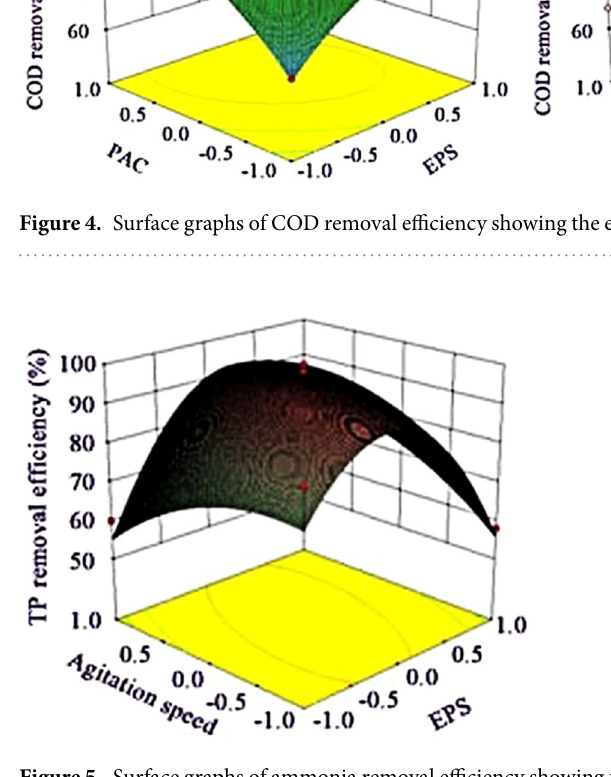
Figure 5. Surface graphs of ammonia removal efficiency showing the effect of variables: PAC